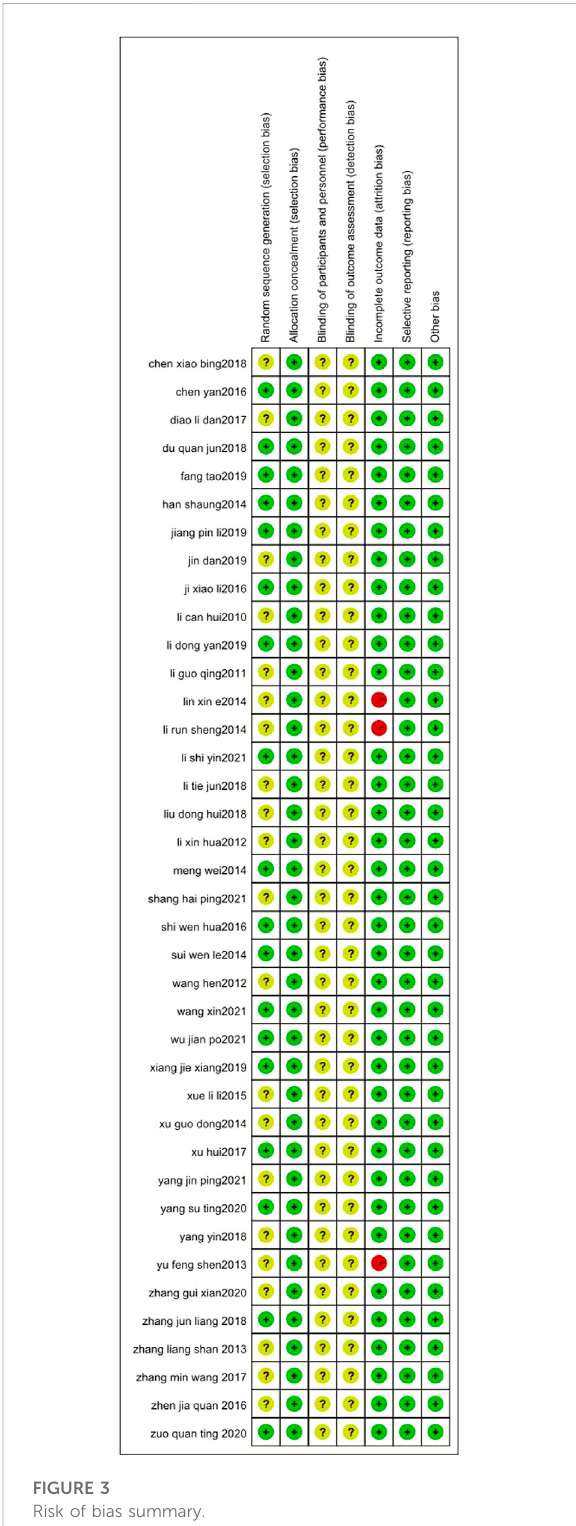
FIGURE 3 Risk of bias